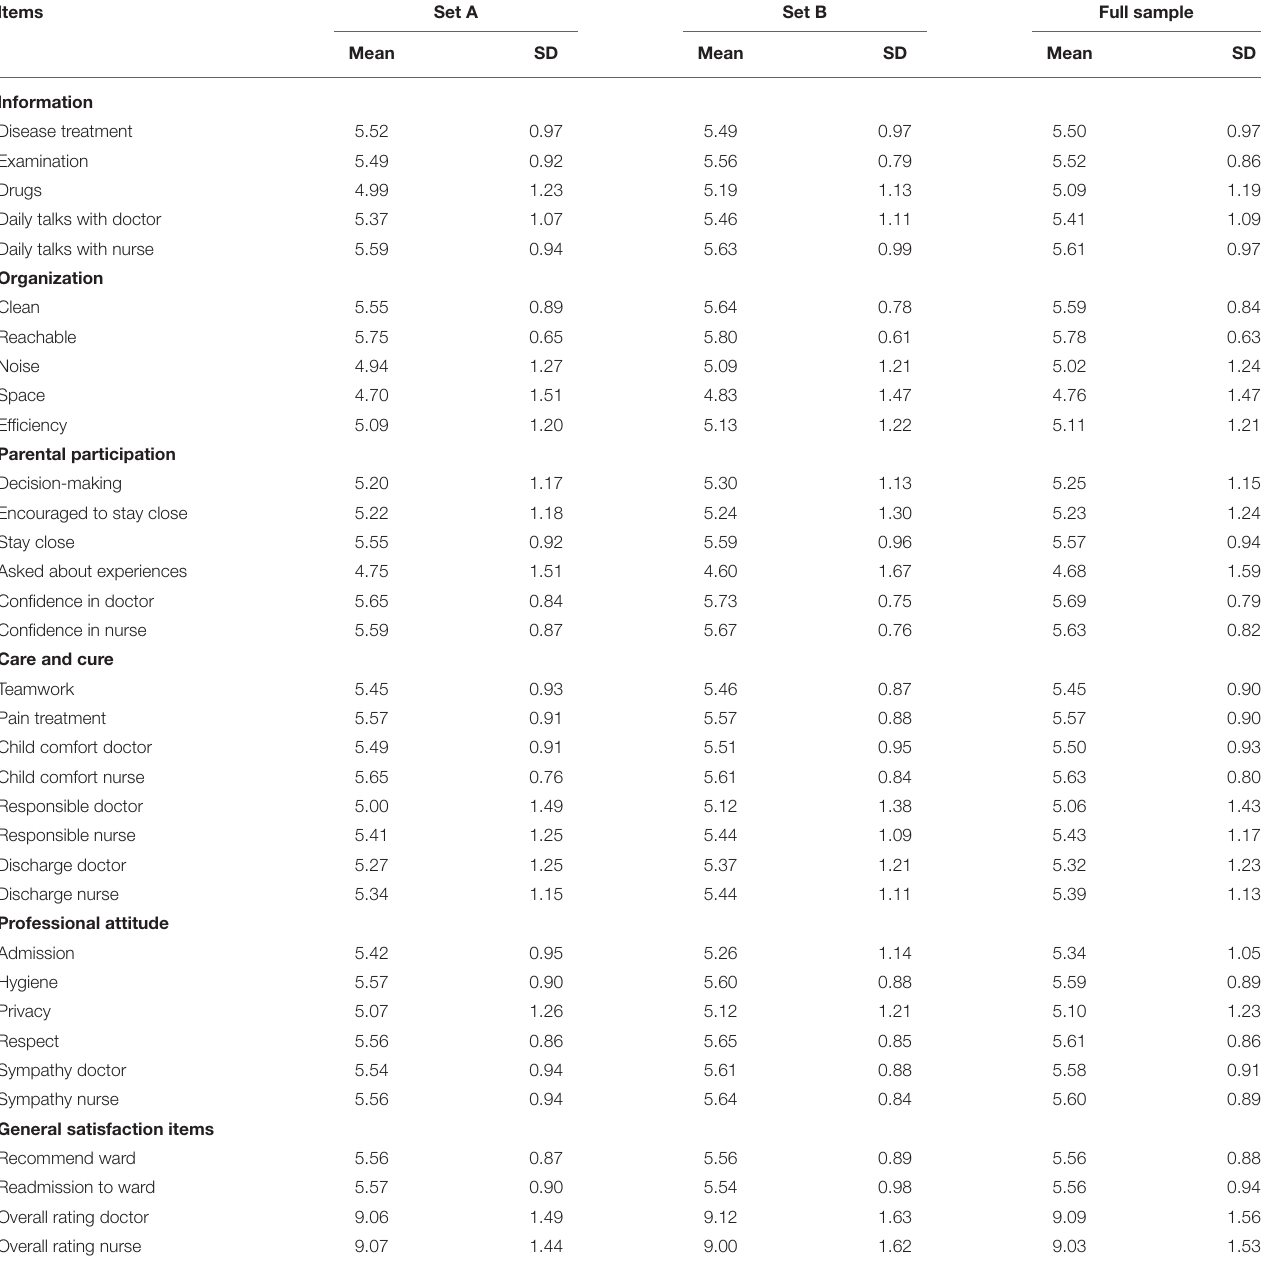
TABLE 2 | EMPATHIC-30 means and standard deviations for set A, B and the full sample.